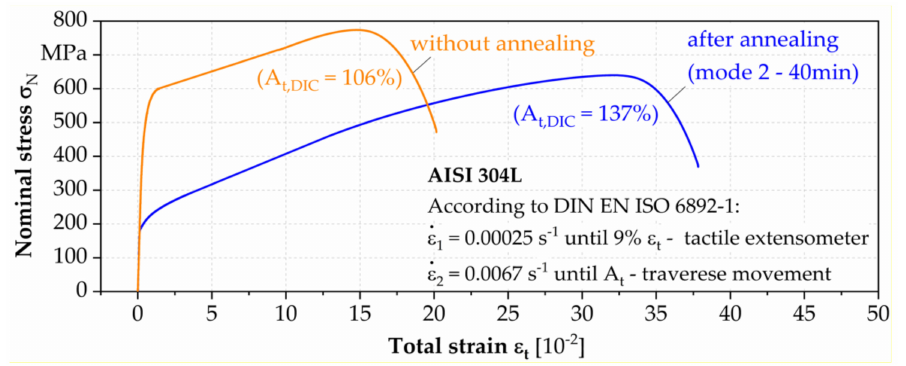
Figure 13. Stress–strain curves of tensile tests for the base material with and without heat treatment according to the brazing